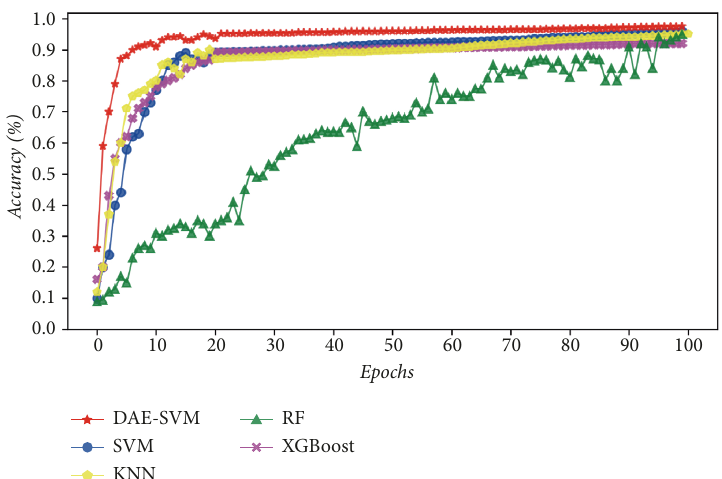
Figure 15: Classification accuracy of different methods.